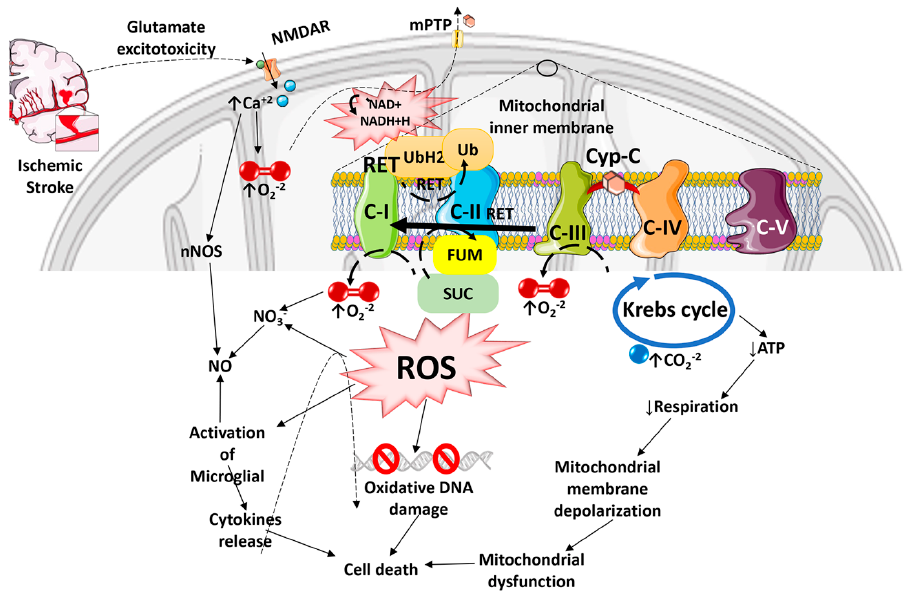
Figure 1. Diagram illustrating how Reactive Oxygen Species especially Reactive Oxygen Species generated by the Reverse Electron Transport process, and the ensuing oxidative stress contributes to mitochondrial dysfunction, cell death, and progressive ischemic stroke pathology. ROS can damage mitochondrial DNA because of the lack of a chromatin-like structure that would protect DNA against ROS insults. ROS can also damage lipids and protein structures in mitochondrial matrix and further exacerbate mitochondrial dysfunction. Mitochondrial ROS released into the cytosol can activate microglia and astrocytes, causing neuroinflammation and death of injured neurons.